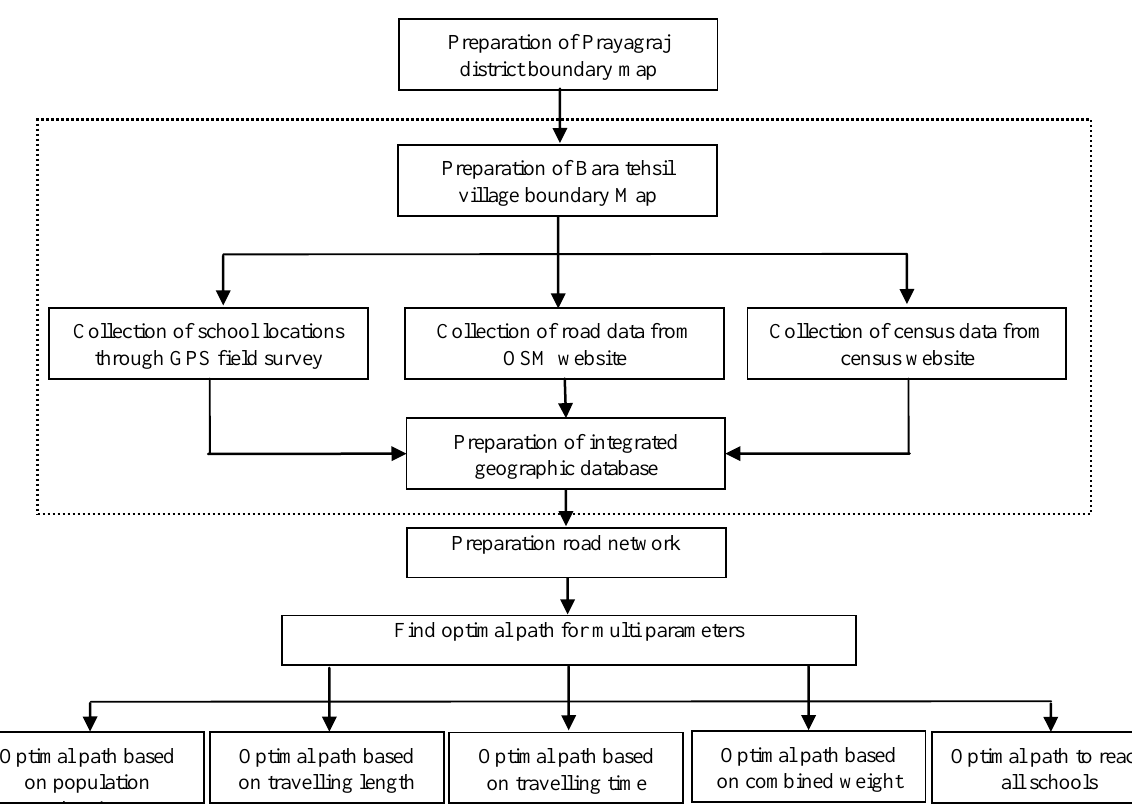
Figure 2. Methodology flow chart